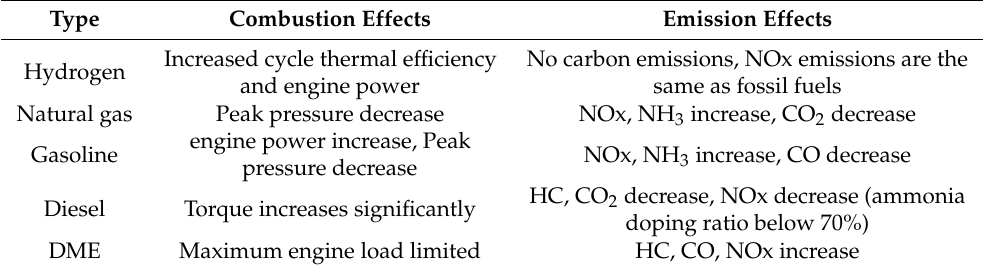
Table 2. Comparison of the combustion characteristics of different fuels after mixing with ammonia. (Compared with the engines using pure fuel in the “Type” column.)